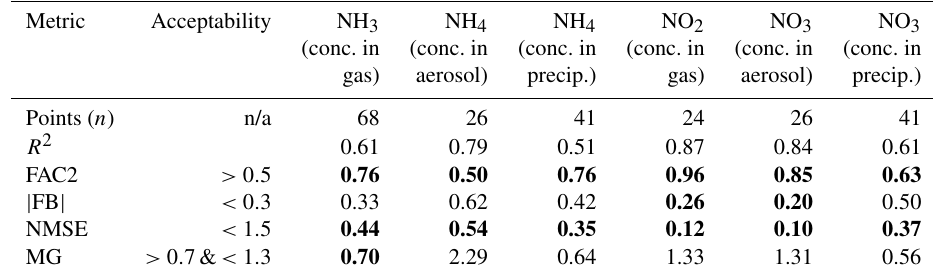
Table 4. Evaluation metrics of modelled concentrations of six nitrogen compounds in gas, aerosol and precipitation in the UK for 2017 (see Table 3 for definitions). Bold numbers represent where that metric has been satisfied (see Sect. 2.4.2 for metric definitions).